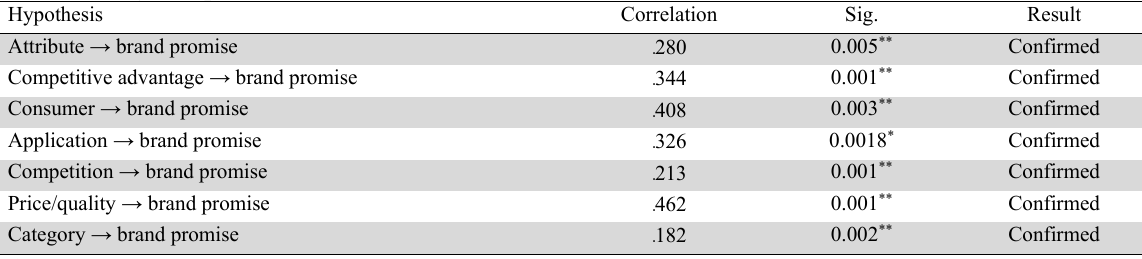
The summary of Spearman correlation test